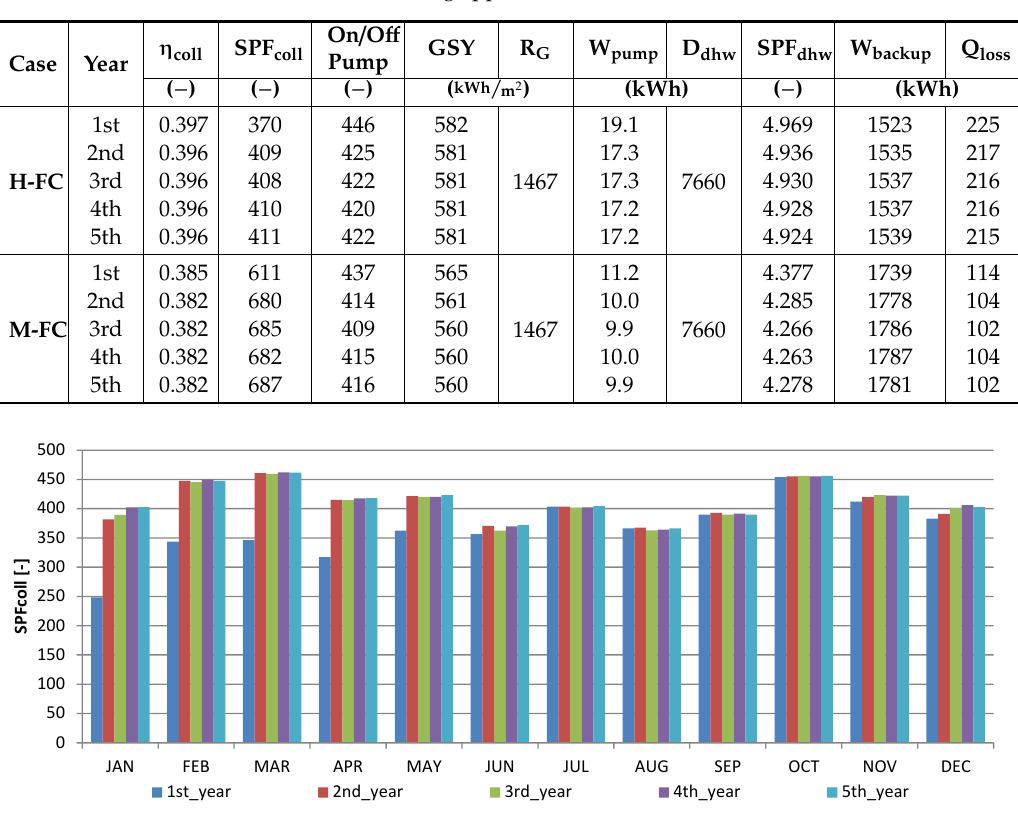
Figure 9. Monthly profile of the SPF coll with Q-learning coupled to the H-FC, comparing the monthly performance of the different year during the learning phase.